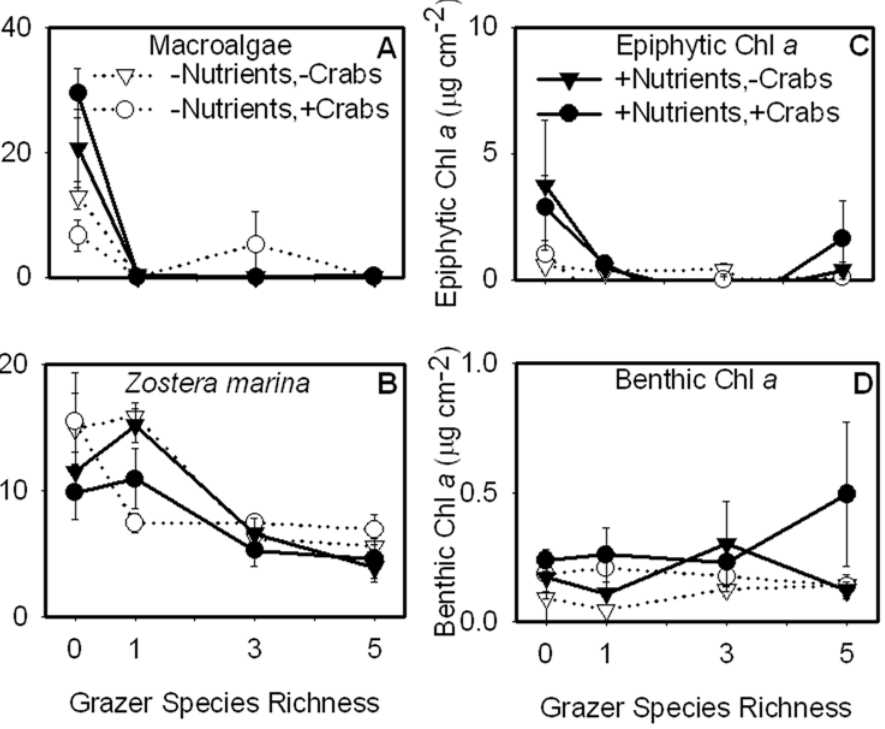
Figure 1. Effects of nutrient enrichment, crab presence, and grazer richness on primary producer biomass. Nutrient enrichment increased macroalgae (A) and epiphytic Chl a (C). Grazers reduced abundances of macroalgae (A), Z. marina (B), and epiphytic Chl a (C). Benthic Chl a (D) was unaffected by the experimental manipulations. For this and the following figures, all error bars are standard error and the statistical results are reported in Table